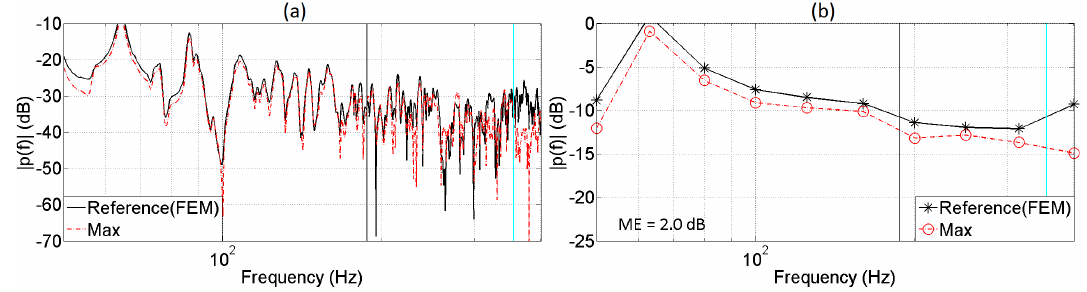
Figure 31. Comparison of full ( a ) and 1/3 octave band ( b ) frequency responses. Translated PWE ( Y ) and reference ( Y ) at translated Position 5.